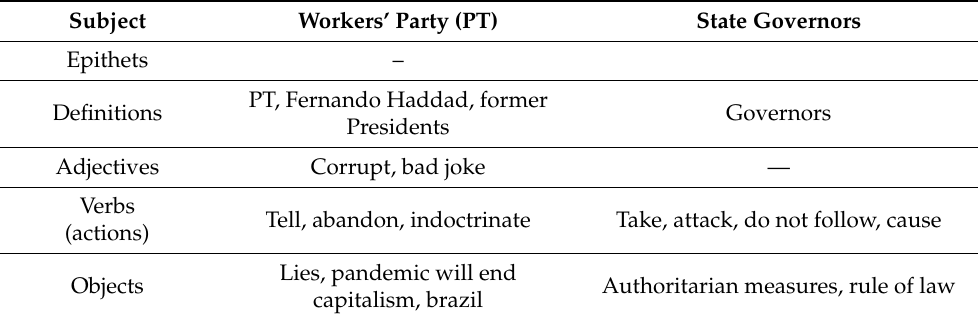
Table 22. Worker’s Party (PT) and State Governors.